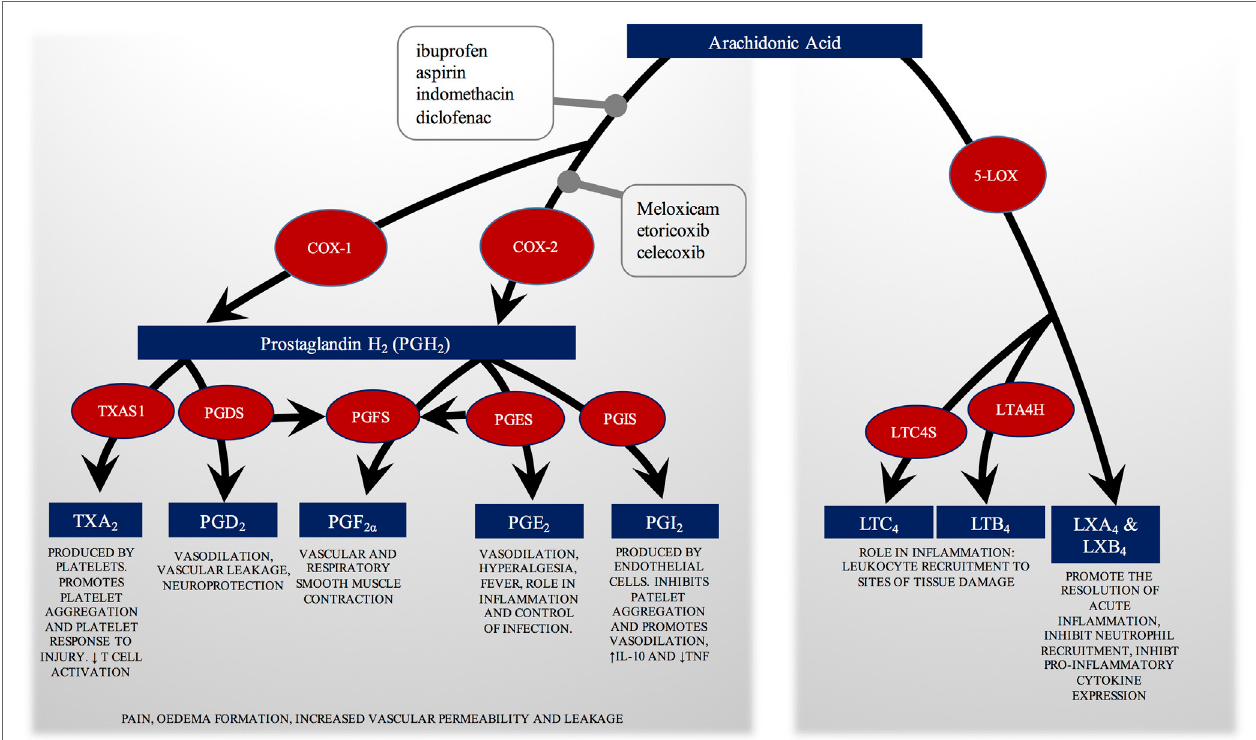
FiGURe 1 | COX and 5-LOX pathways of eicosanoid biosynthesis from arachidonic acid. The physiological role of each eicosanoid and eicosanoid group is explained. The figure shows where the non-steroidal anti-inflammatory drugs (NSAIDs) evaluated in this review have an effect, blocking both COX enzymes or the COX-2 selectively. By inhibiting the COX enzymes, NSAIDs inhibit prostaglandin synthesis. They also promote a switch to arachidonic acid oxidation by 5-LOX. COX, cyclooxygenase; LOX, lipoxygenase; TXA, thromboxane; TXAS, thromboxane synthase; PG, prostaglandin; PGDS, PGD synthase; PGFS, PGF synthase; PGES, PGE synthase; PGIS, PGI synthase; LT, leukotriene; LTC4S, LTC 4 synthase; LTA4H, LTA 4 hydrolase; LX,